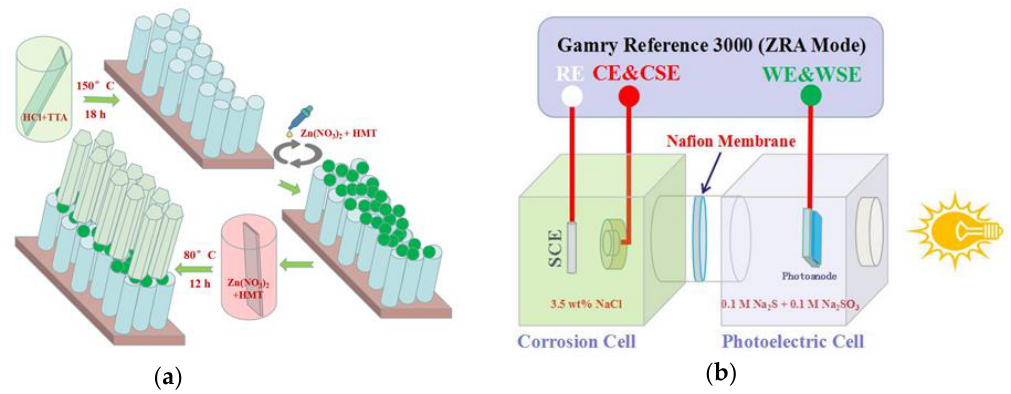
Figure 1. ( a ) Schematic illustrations of the preparation process of the ZnO / TiO 2 heterojunction double layer film. ( b ) Schematic diagram of the double electrolytic cell setup for the measurement of OCP and photocurrent density.